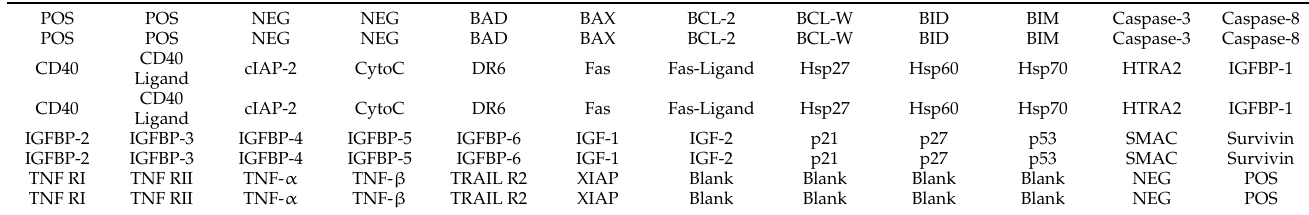
Table 2. Apoptosis array